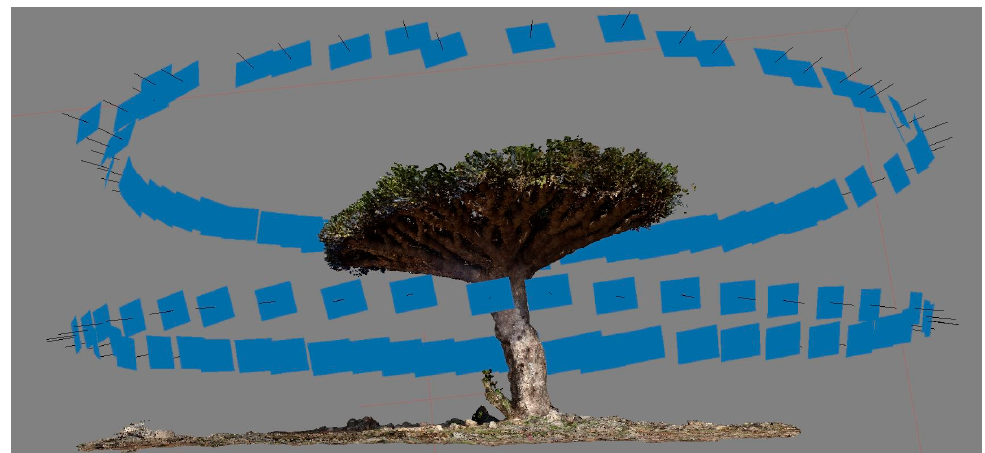
Figure 2. Method (b)—position of captured photos to create a photogrammetric 3D tree point cloud. Two circles of photos capture the tree from two vertical angles. The upper circle captures the crown surface, the lower circle captures the stem and the inner structure of the crown.